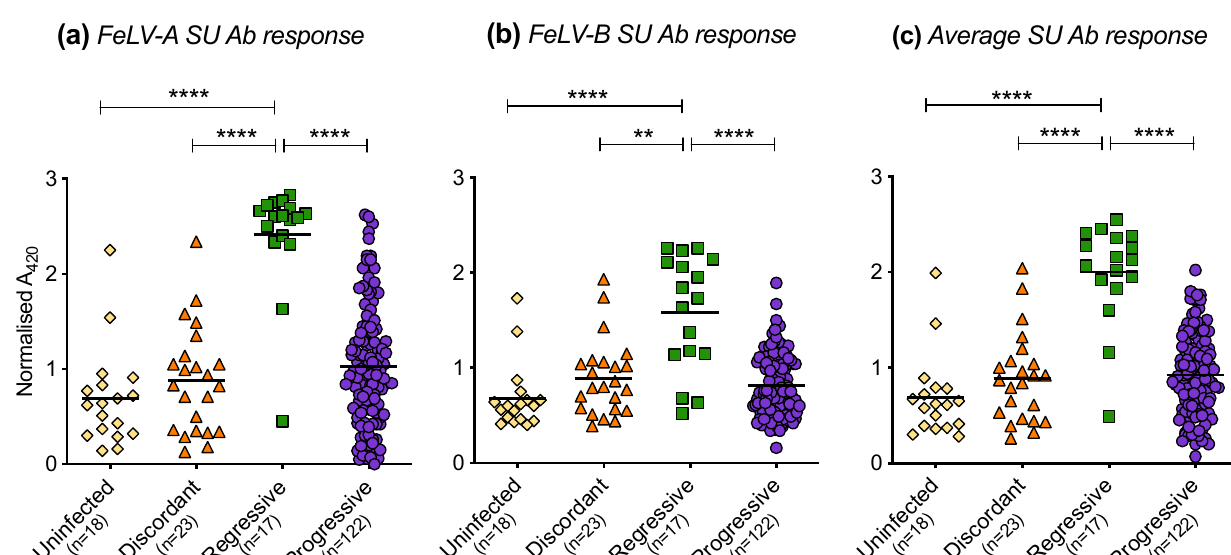
Figure 12. FeLV-A, FeLV-B and average SU antibody responses in different exposure outcome groups. Plasma samples were tested for antibodies recognising FeLV-A SU ( a ) and FeLV-B SU ( b ) proteins and the average SU antibody (Ab) responses are shown ( c ). Statistical significance was determined using Kruskal–Wallis and Dunn’s multiple comparisons tests ( p -value < 0.01 ** and < 0.0001 ****).